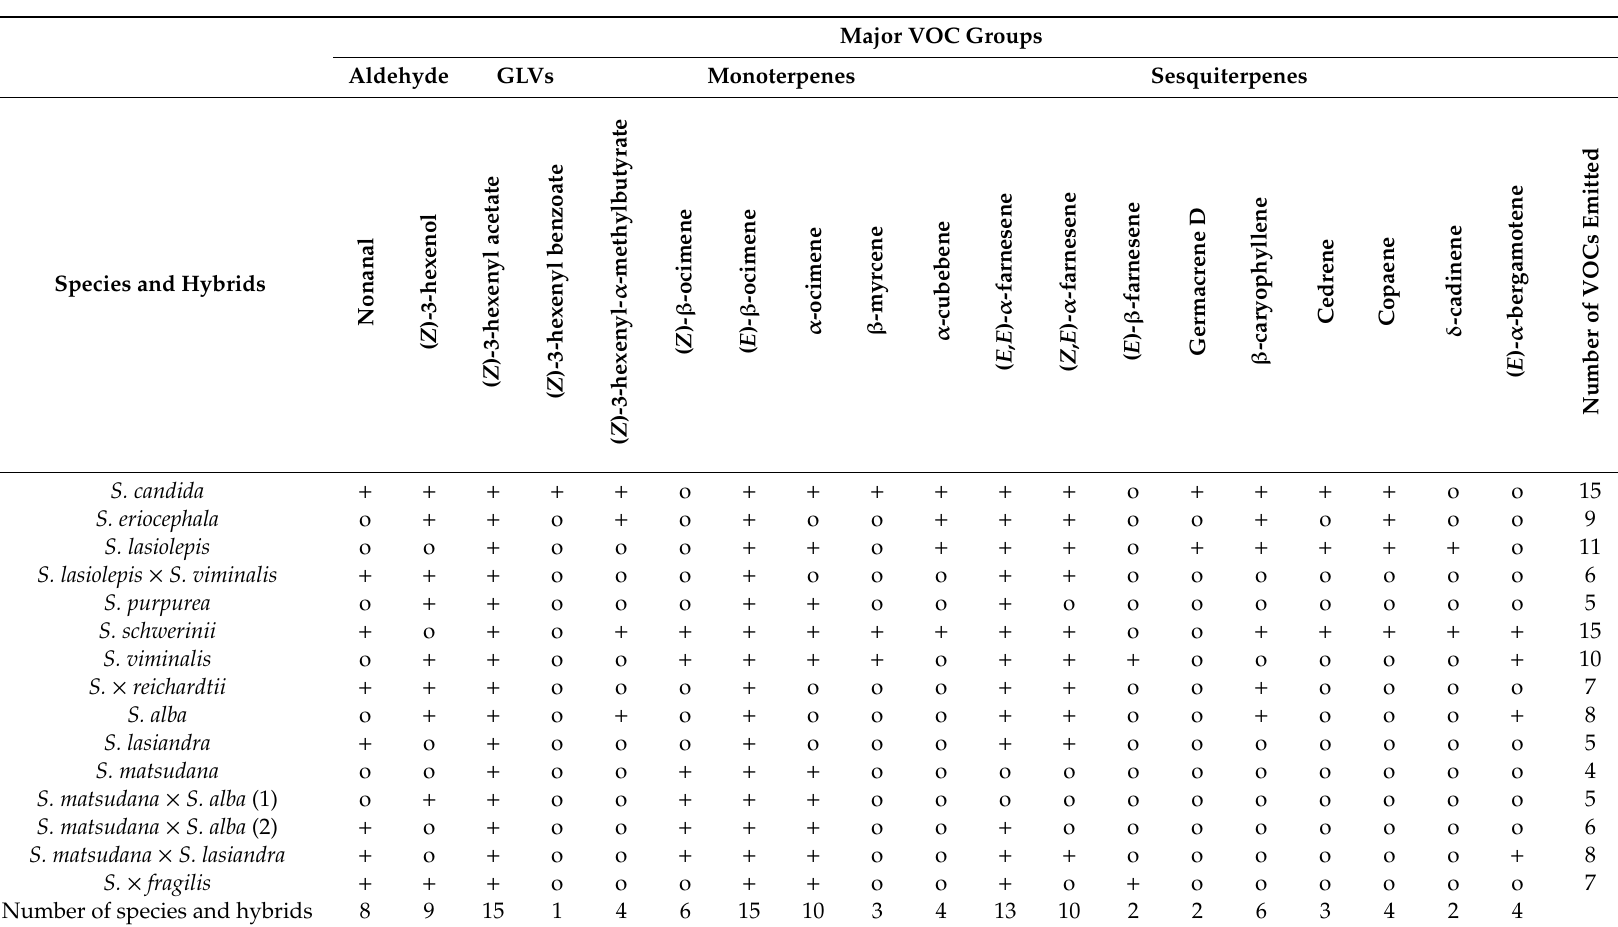
Table 2. Gas chromatography-mass spectrometry (GC-MS) analysis of VOCs released from the foliage of fifteen willow species and hybrids. Major VOC Groups Aldehyde GLVs Monoterpenes